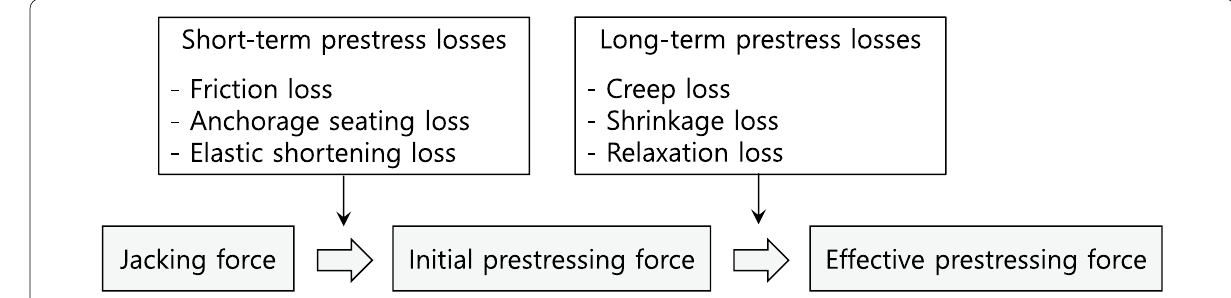
Fig. 2 Short‑ and long‑term prestress